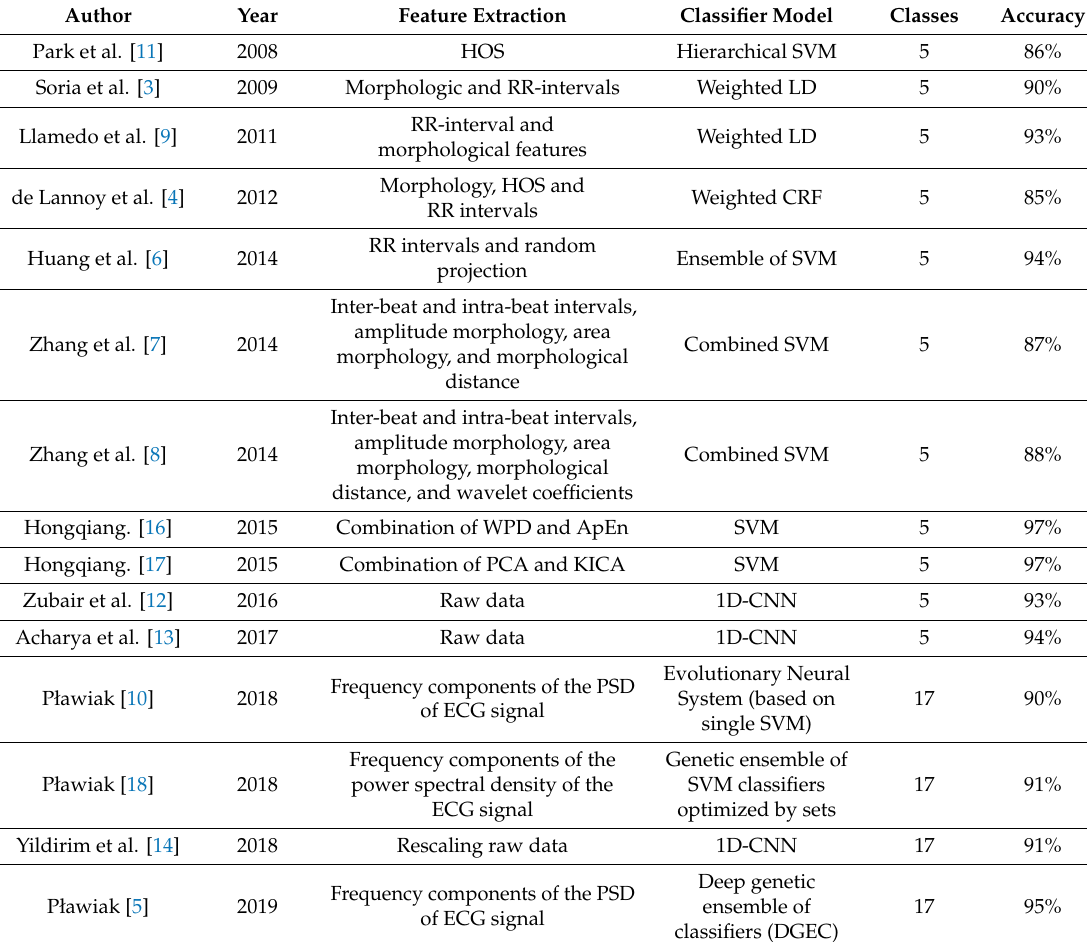
Table 1. Related work of ECG